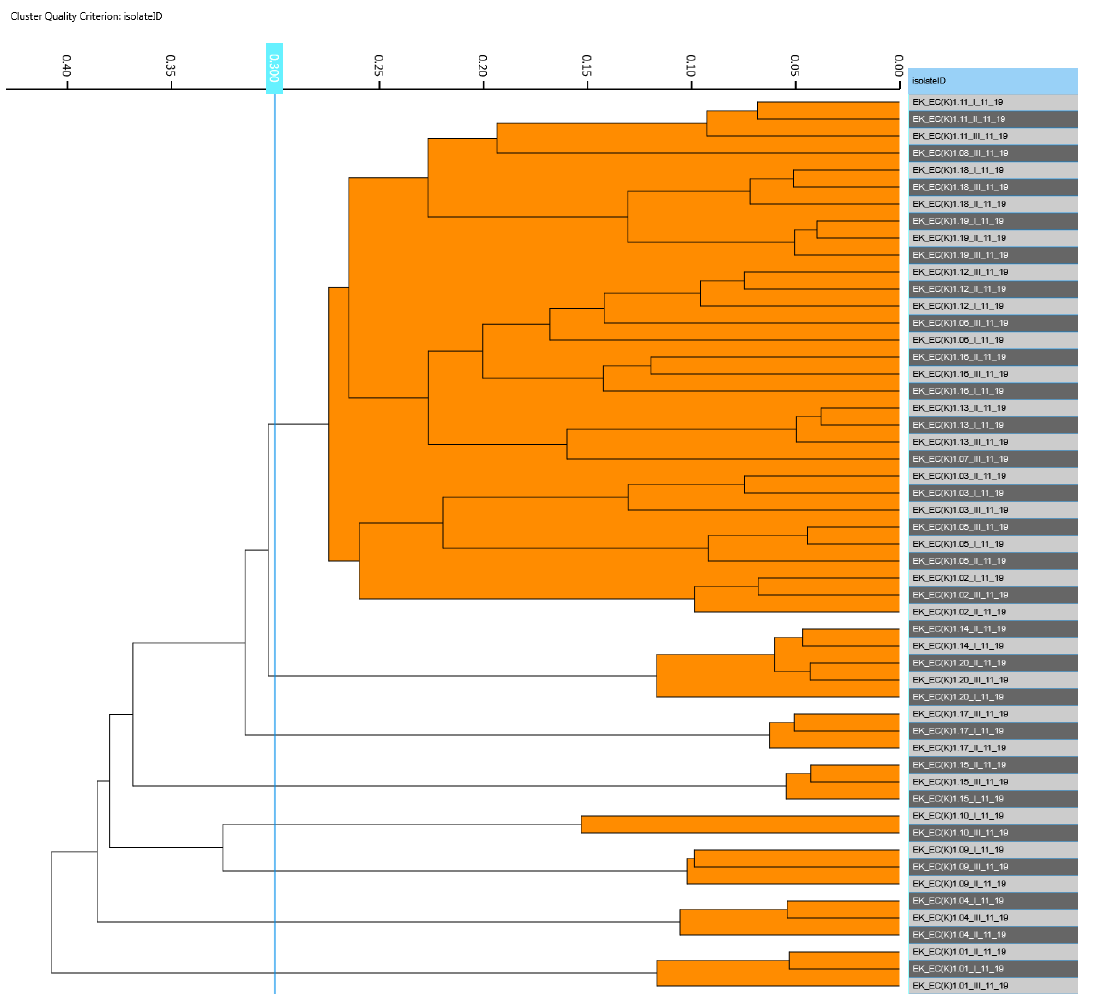
Figure 5. Example of a dendrogram of FT-IR spectra obtained from E. coli strains isolated from pigs and chickens kept in pasture 1 (mixed husbandry; third sampling run). The blue line indicates the stable cut-off value of 0.300. A main cluster is in the upper horizontal plane. The right side, highlighted in dark and light gray refers to E. coli strains coming from animals. The abbreviation, for example “EK_EC(K)_1.11_I_11_19” stands for: EK = name of author; EC(K) = E. coli (K = cloacal) 1.11 = Pasture 1, chicken no. 1 (no. 01 – 10 = pigs, no. 11 – 20 = chickens); I = first biological replicate;